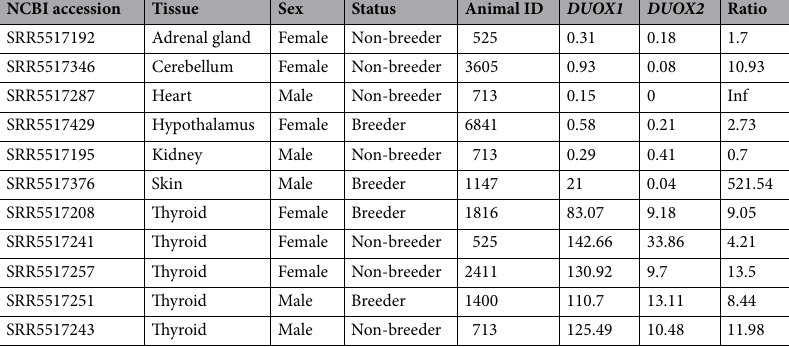
Table 2. DUOX1 and DUOX2 gene expression in naked mole-rat as transcripts per million